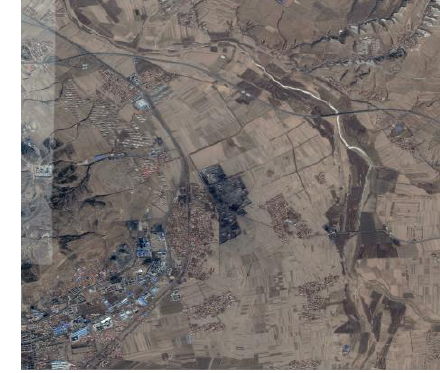
Fig.2 optical image of Yuanbaoshan District, Chifeng City,